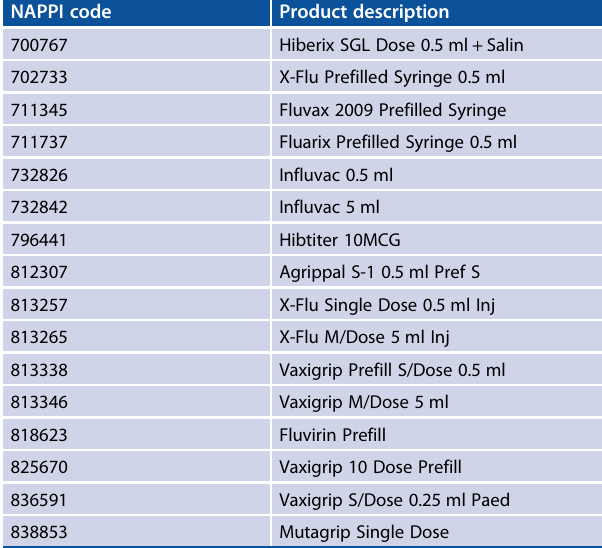
Table 1: List of vaccine products provided to medical scheme